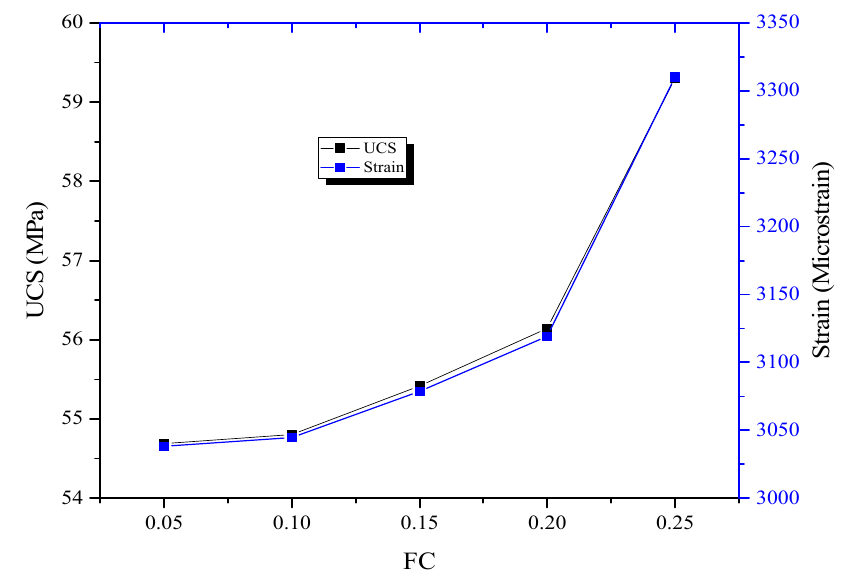
Figure 12. Variation of peak stress and strain with frictional coefficient (FC).